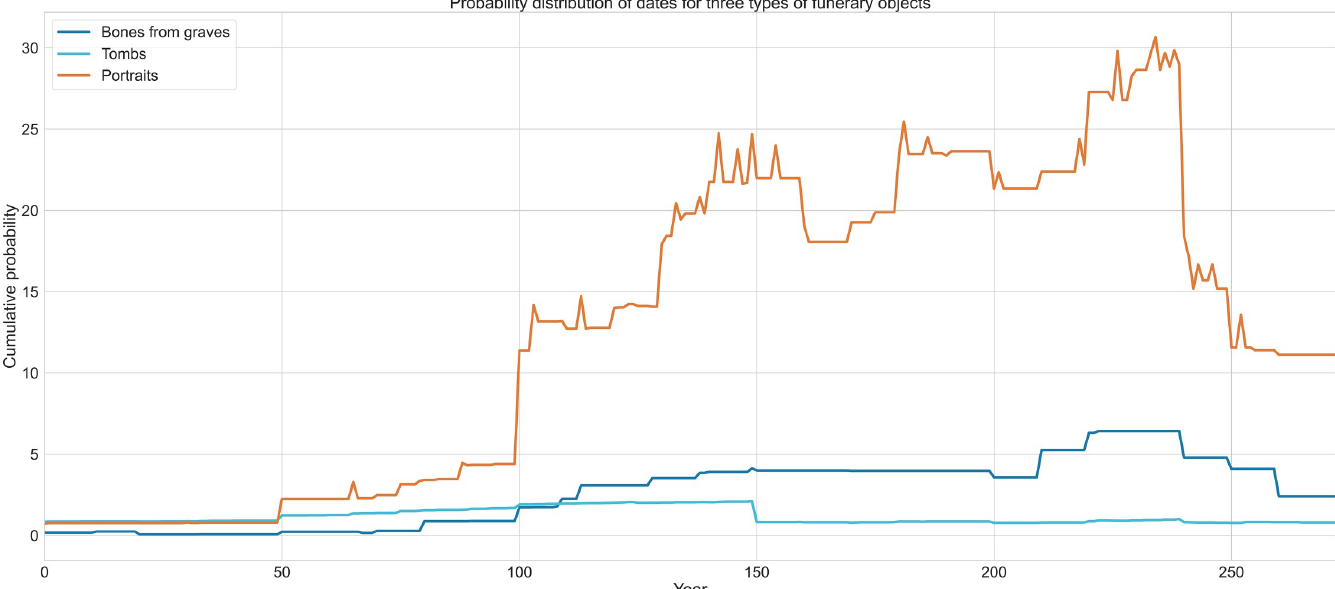
Fig 7. Probability distribution of portraits depicting men, women and children. Graph ©